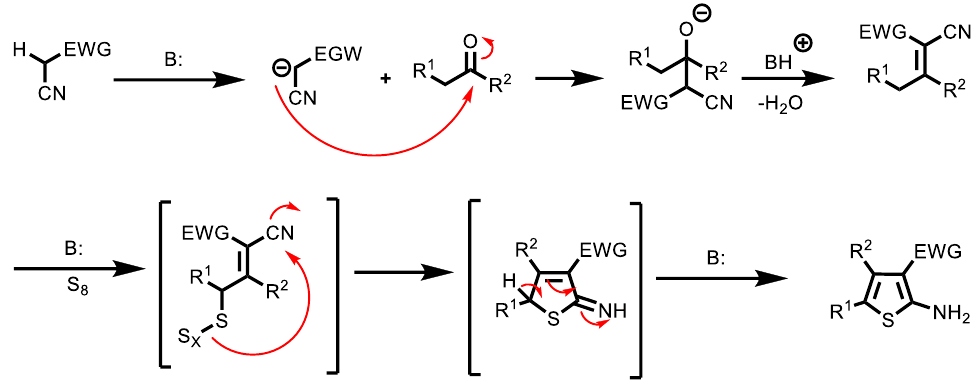
Figure 5. Evolution of cancer treatment.